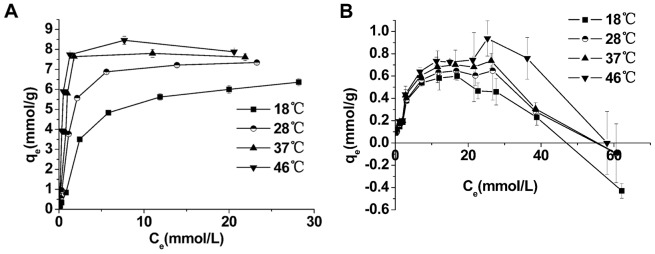
The Ag+ adsorption isotherms at different temperatures for BMO (A) and CMO (B).